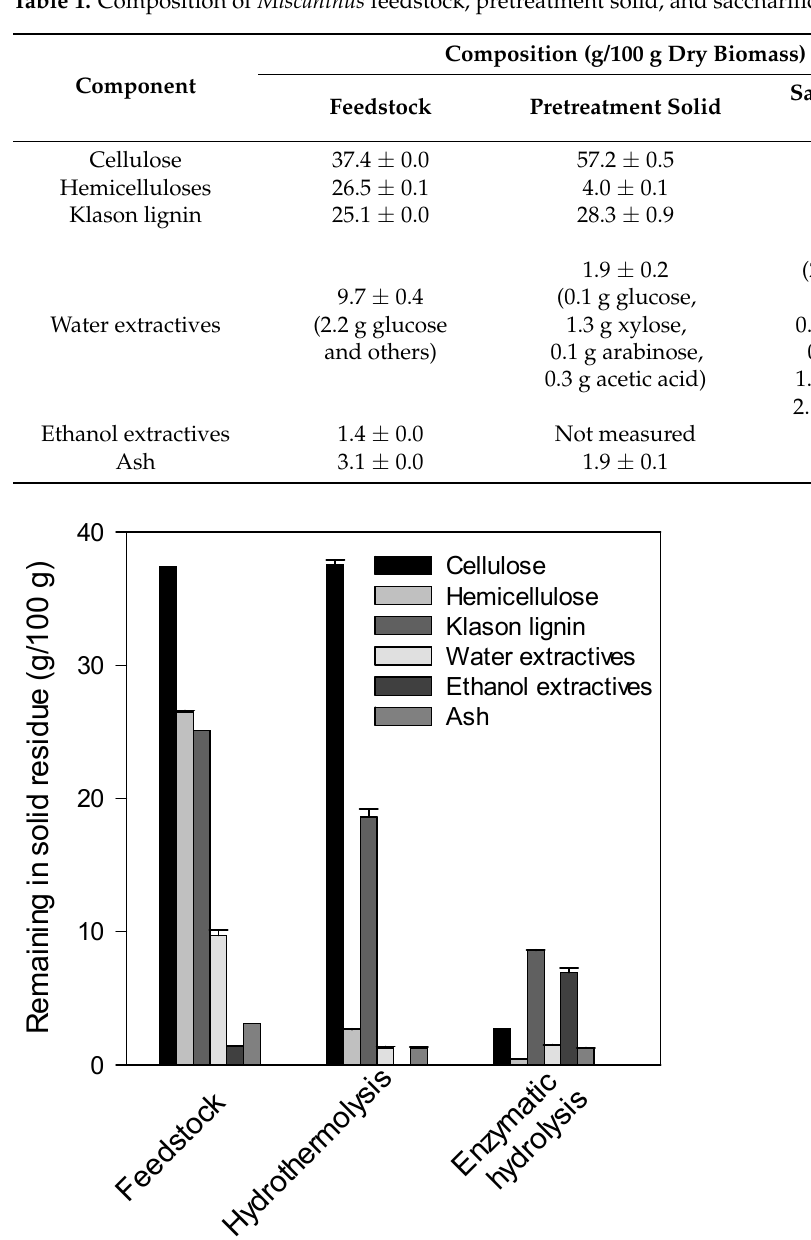
Figure 1. Each component remaining in dry solid during fermentable sugar production with Miscanthus .